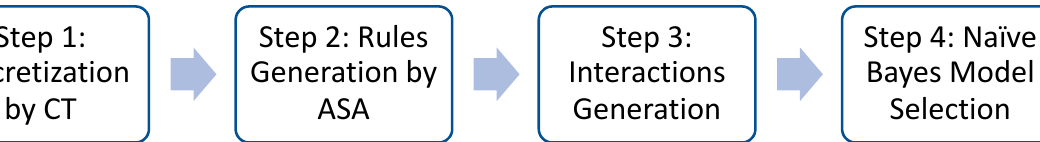
Figure 1. Naïve Bayes classifier framework.